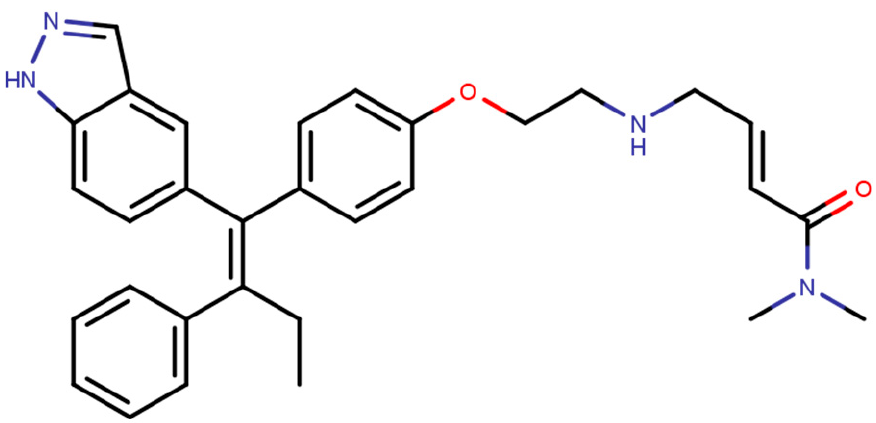
Figure 12. Structure of LBD-directed covalent inhibitor, H3B-5942.